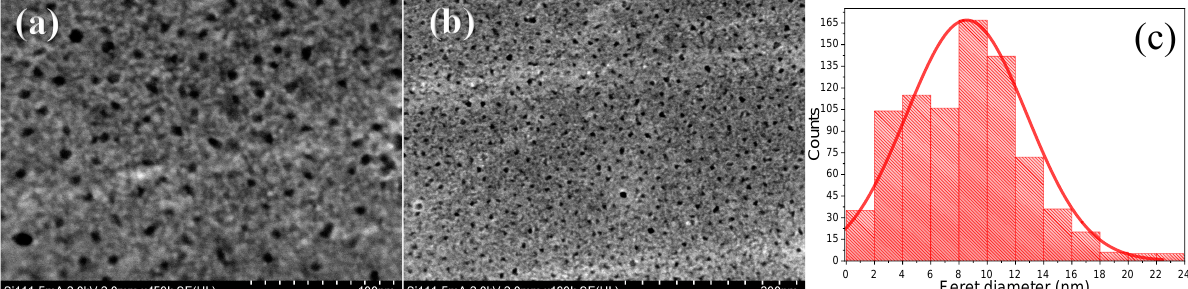
Figure 7. ( a , b ) PSi surface SEM image of PSi fabricated at 5mA/cm 2 . ( c ) Porous size distribution obtained by SEM images analysis using ParticleSizer by ImageJ software (open source) [36]. Distance in pixels is fixed using the reference bar of the SEM image. Then, a good part of the SEM image is selected for size analyzes. ImageJ threshold tool is used to set manually lower and upper lightness threshold values segmenting grayscale images into features of interest and background. If it is requiring, a bandpass filter can be applied to improve the porous edge determination. Finally, porous edges are created by tracing objects of uniform color or thresholded objects. Particle or pore size of thresholded images can be extracted by specifying the suitable edge ranges and choosing if their outer edge or flood filling should trace particles.